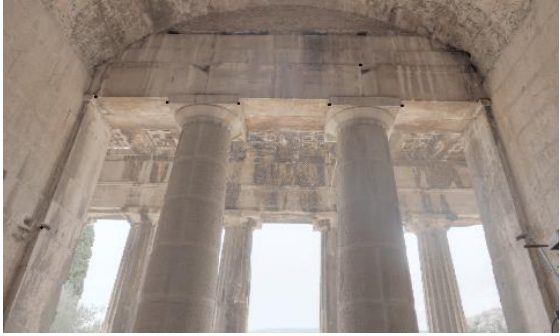
Figure 10: Implementation 3: Difficulty to